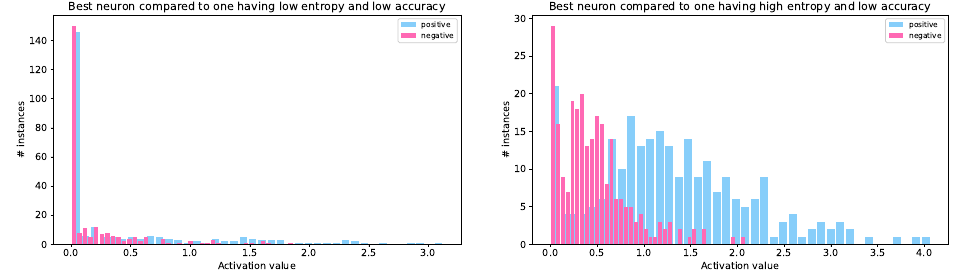
Figure 7. For the cyclomatic complexity classification, we show the outcome of our comparison between the best neuron in the task and two neurons not performing the same, with the first having low entropy ( left ) and the second one having high entropy ( right